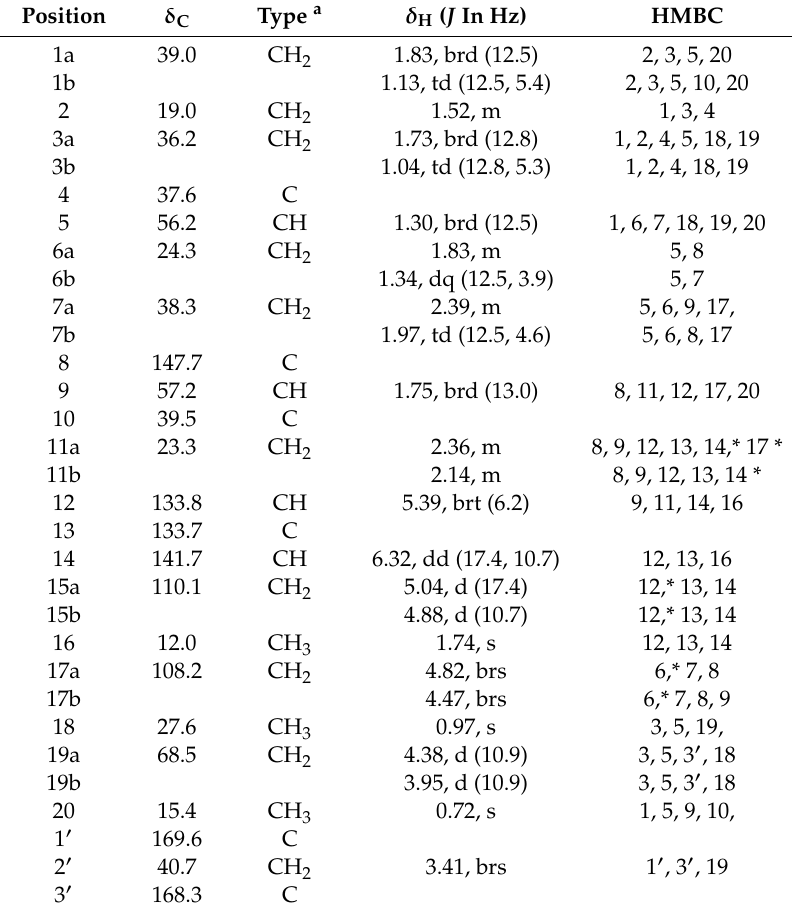
Table 1. NMR Data ( 1 H 700 MHz and 13 C 175 MHz, CDCl 3 ) of 1 . Position δ